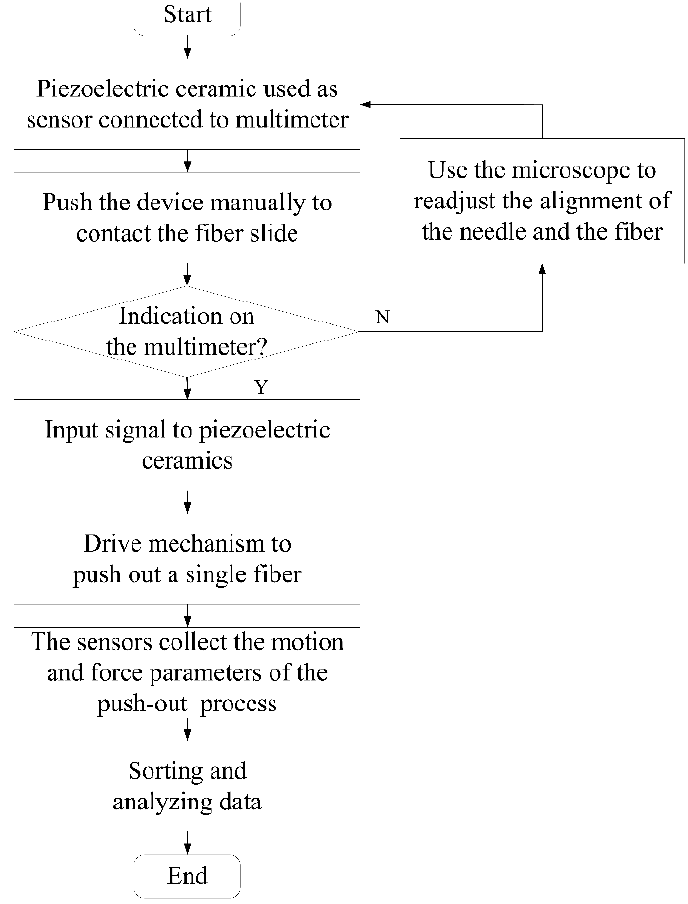
Figure 14. Test flow chart.